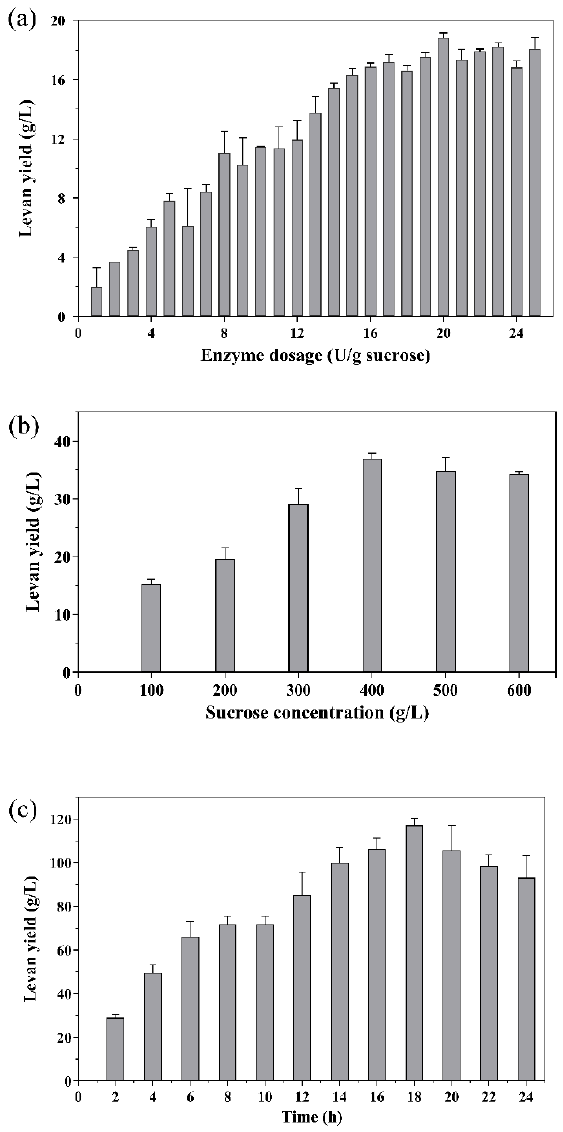
Figure 5. Optimization of enzyme dose, sucrose concentration, and reaction time on levan synthesis. ( a ) The effect of enzyme dose on levan synthesis. ( b ) The effect of sucrose concentration on levan synthesis. ( c ) The effect of reaction time on levan synthesis.